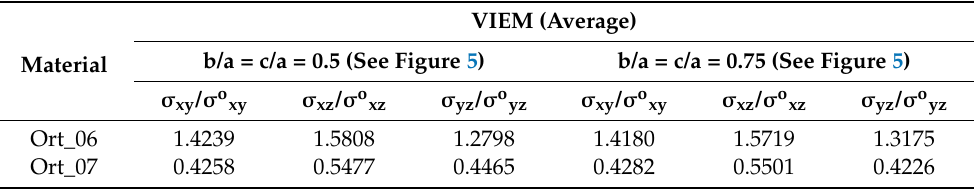
Table 23. Normalized shear stress components ( σ xy / σ o xy , σ xz / σ o xz and σ yz / σ o yz ) within the orthotropic oblate spheroidal inclusion due remote shear loading ( σ o xy , σ o xz and σ o yz ). VIEM (Average) b/a = c/a = 0.5 (See Figure 5) b/a = c/a = 0.75 (See Figure 5) Material σ xy / σ o xy σ xz / σ o xz σ yz / σ o yz σ xy / σ o xy σ xz / σ o xz σ yz / σ o yz Ort_06 1.4239 1.5808 1.2798 Ort_07 0.4258 0.5477 0.4465 0.4282 0.5501